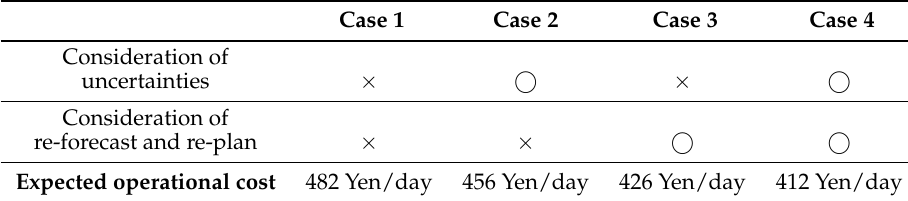
Figure 13. Histogram of operational cost in each case. Table 4. Expected operational cost for 1000 scenarios in each